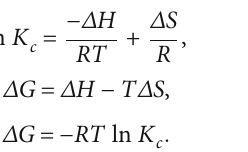
NCs versus time. 2